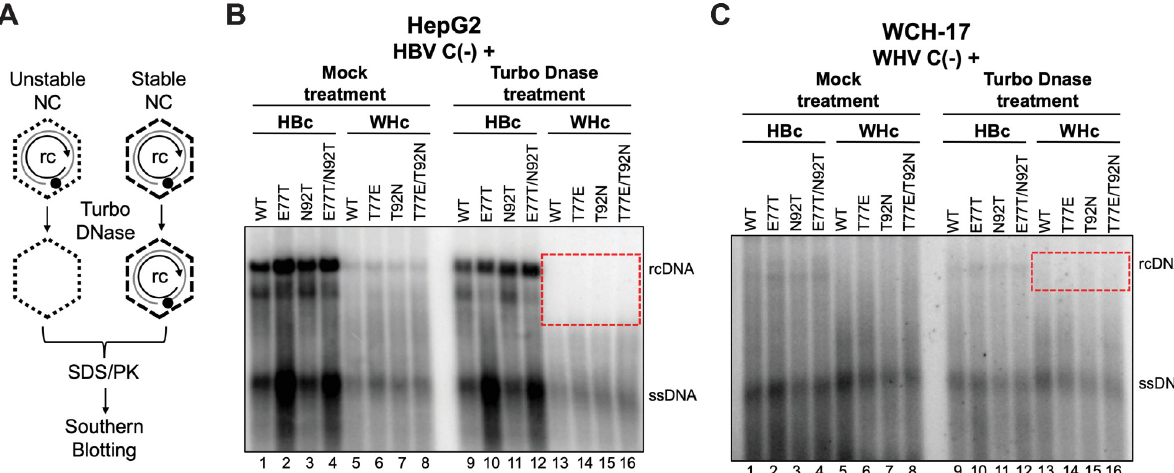
Fig 7. Effects of HBc or WHc on protecting the rcDNA content inside NCs. (A) schematic diagram of nuclease treatment of HBV or WHV NCs. Turbo DNase was used to degrade viral DNA inside unstable NCs. Following inactivation of the nuclease, NC-protected DNA was isolated and detected by Southern blot analysis. Core DNA released from the cytoplasmic lysate of WT and mutant HBc or WHc co-transfected with HBV-C(-) from HepG2 cells (B) or with WHV-C(-) from WCH-17 cells (C) , with or without prior Turbo DNase digestion, was detected by Southern blot analysis. The rcDNA signals obtained after Turbo DNase treatment is indicated by the dashed, red box for comparison to rcDNA signals present without nuclease treatment. ssDNA, single strand DNA; rcDNA, relaxed circular DNA.